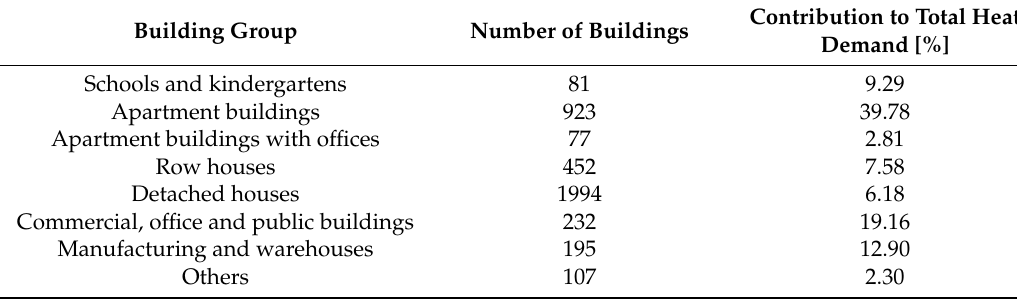
Table 2. Different building groups and their number and contribution to the total heat demand for heating season